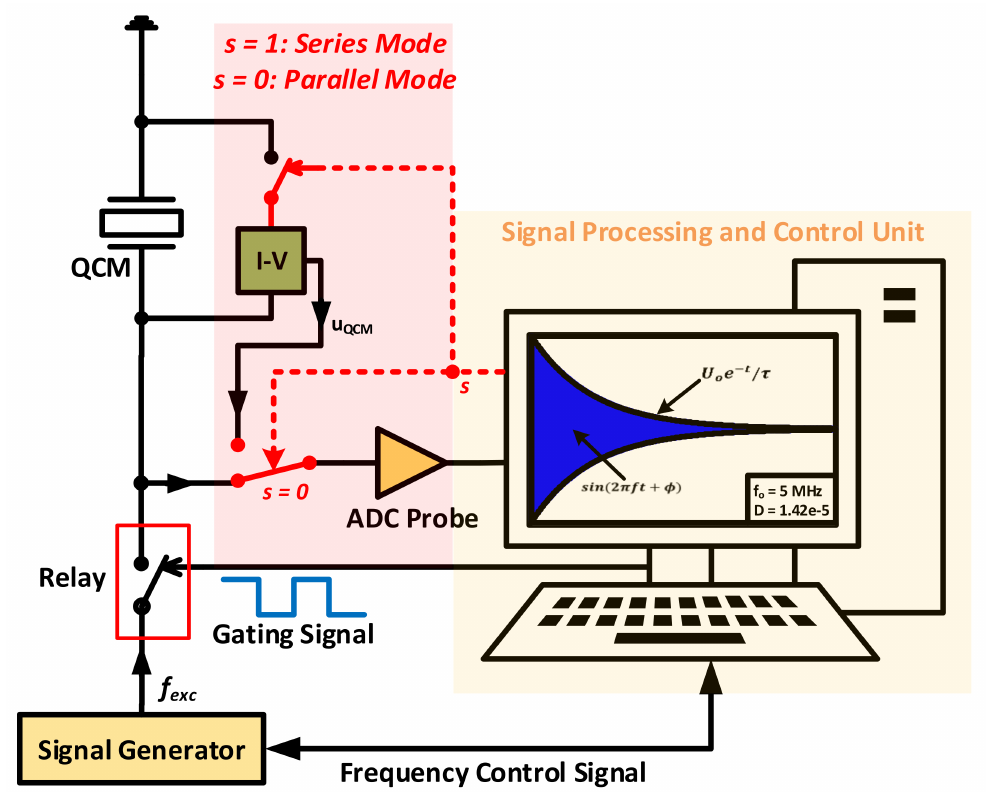
Figure 21. Conventional exponential decay based system for series and parallel resonance